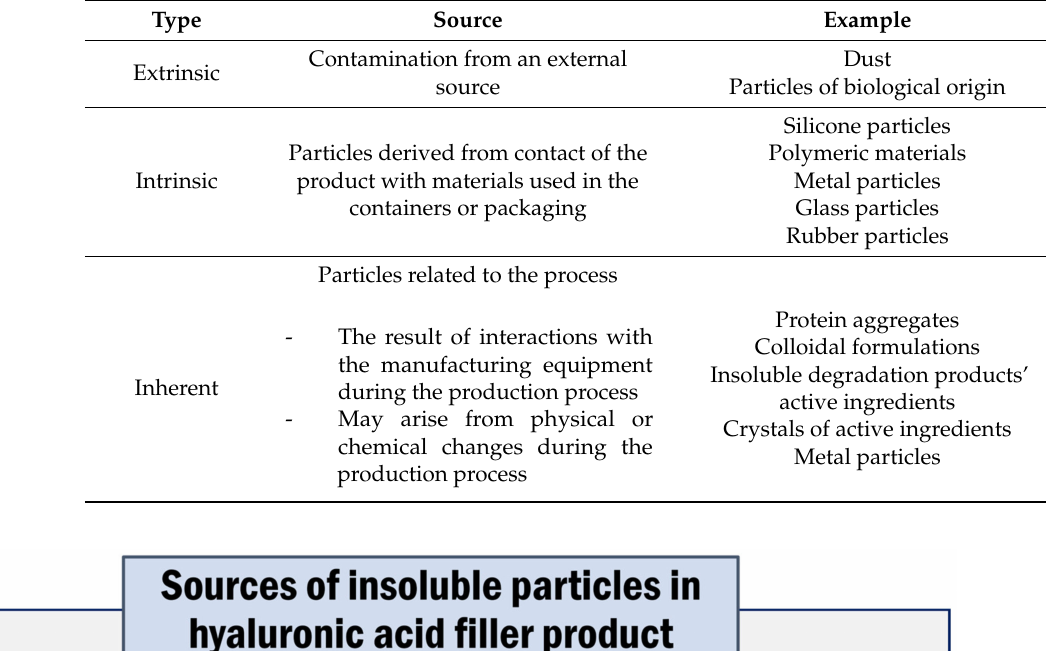
Table 3. Types of particles in the injectables as described in USP [10].